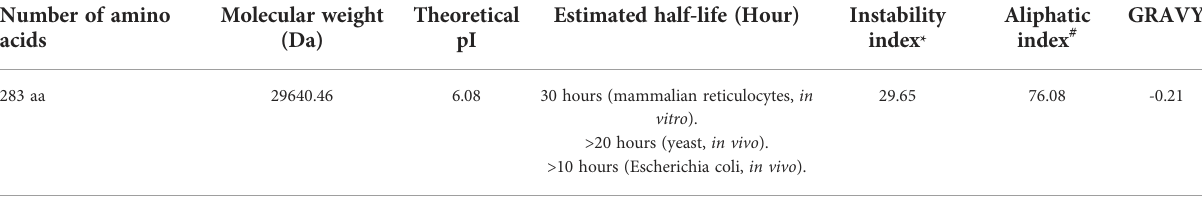
TABLE 2 Physicochemical parameters of the MP3RT vaccine predicted by the ExPASy ProtParam server. Number of